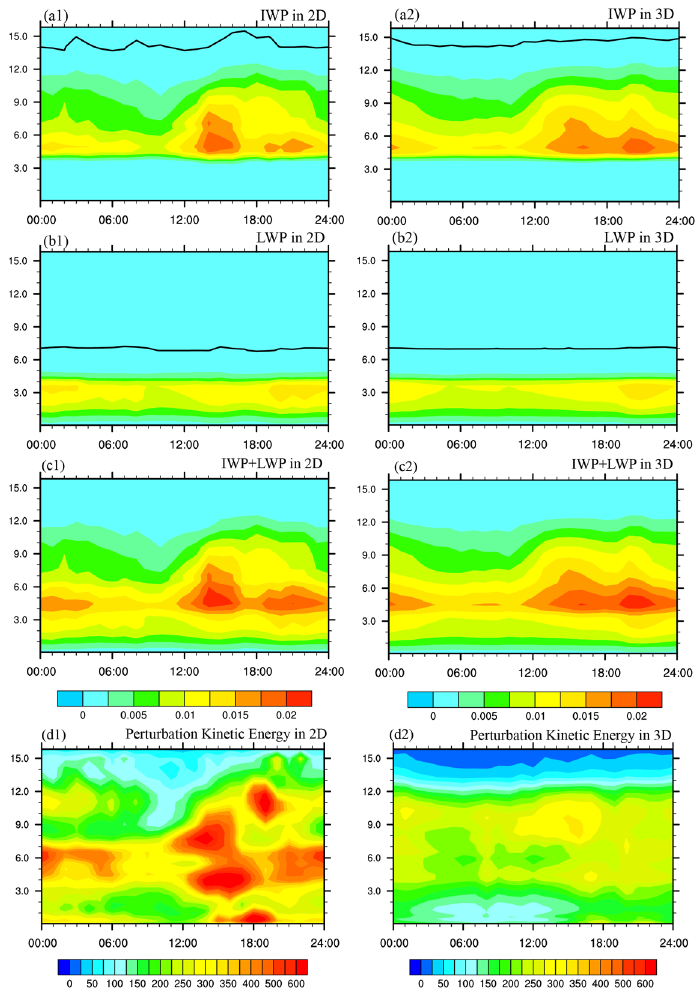
Figure 4. Diurnal composite of ( a1 ) IWP, ( b1 ) LWP, ( c1 ) IWP+LWP, and ( d1 ) perturbation kinetic energy in the 2D model runs and ( a2 ) IWP, ( b2 ) LWP, ( c2 ) IWP+LWP, and ( d2 ) perturbation kinetic energy in the 3D model runs. The units are mm for IWP+LWP and J m − 2 for the perturbation kinetic energy. Black lines in ( b1 , b2 ) indicate liquid cloud tops, while those in ( a1 , a2 ) indicate ice cloud tops. It was supposed that PKE could represent cloud development related to secondary circulations, and secondary circulations can be measured based on PKE [49,67].